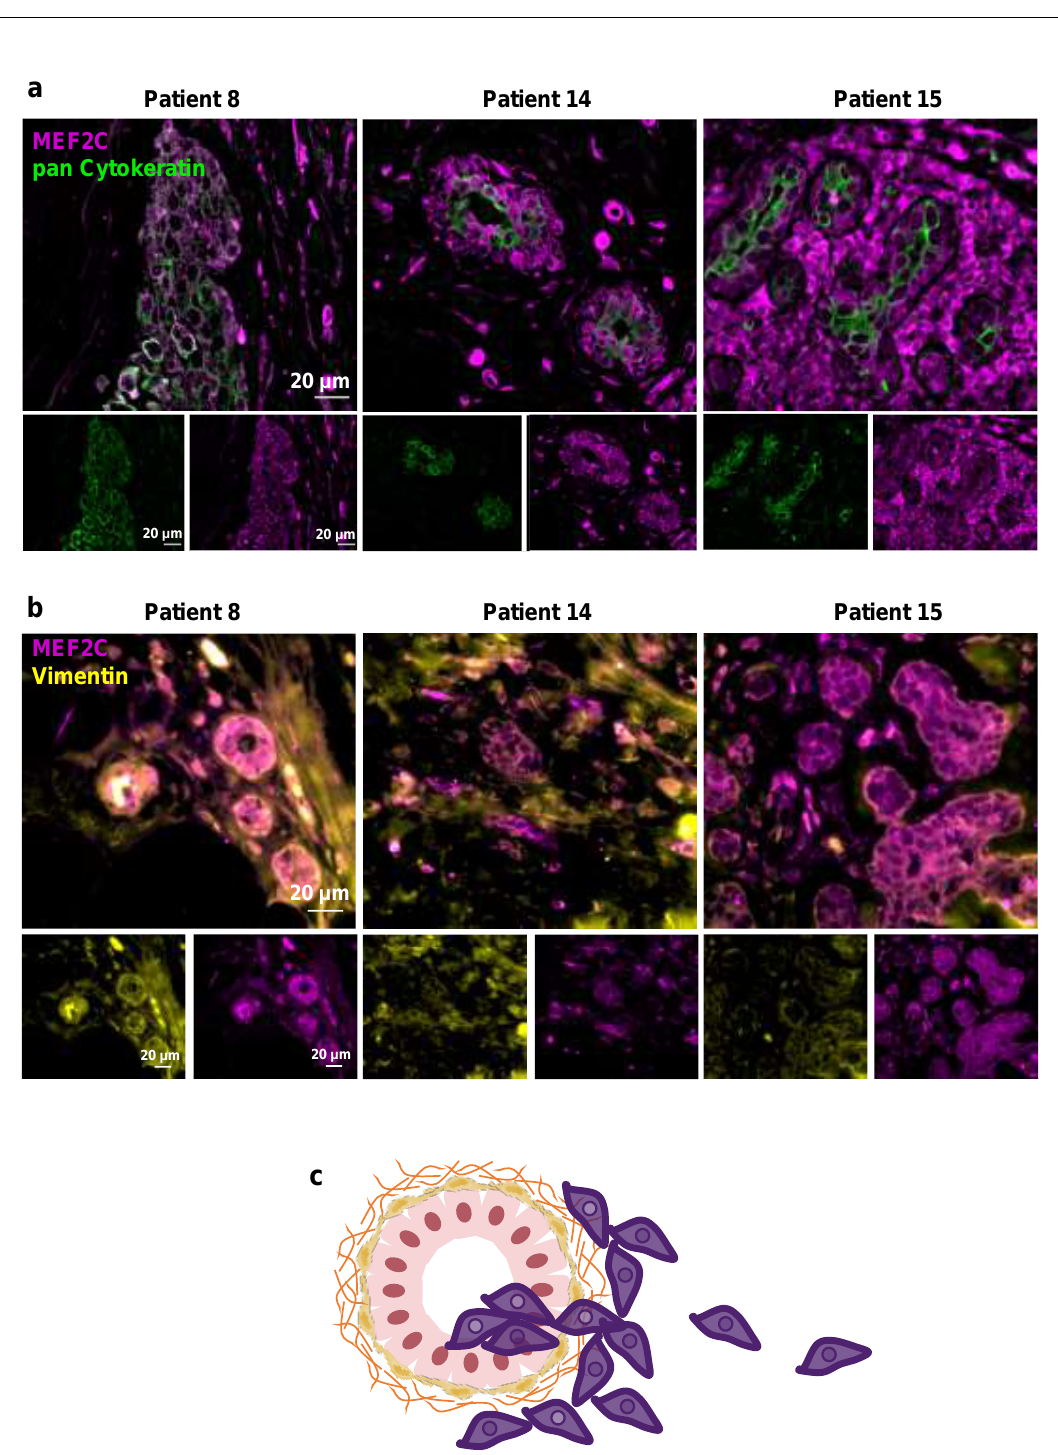
Figure 2. Myocyte Enhancer Factor 2C expression in human breast cancer primary tumors. Double immunofluorescence analysis of myocyte enhancer factor 2C (MEF2C; purple) with the epithelial and tumoral marker, pan Cytokeratin (green), showed that MEF2C expressing cells did not significantly express pan Cytokeratin and were found in disorganized mammary ducts as well as in the surrounding tissue ( a ). Double immunofluorescence analysis of MEF2C (purple) with the mesenchymal marker, vimentin (yellow), showed that MEF2C expressing cells in mammary ducts also expressed vimentin ( b ). Schematic representation of the first stages of the metastatic cascade, showing MEF2C expressing cells (purple) in the mammary duct and invading the surrounding tissue ( c ). Three resected human primary BC cases were studied; ten fields per section and one section per case were analyzed.